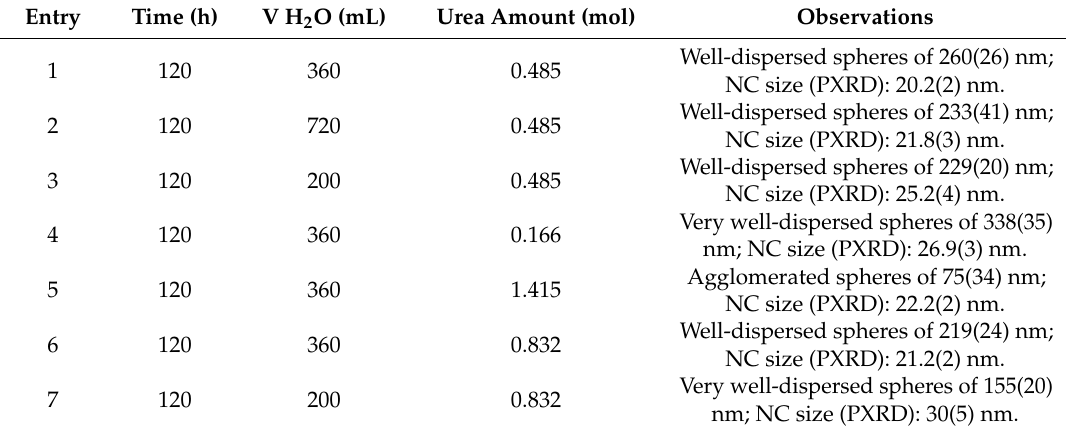
Table 3. Optimization parameters for the synthesis of Y 2 O 3 : Pr 3+ NCs by homogeneous precipitation method.